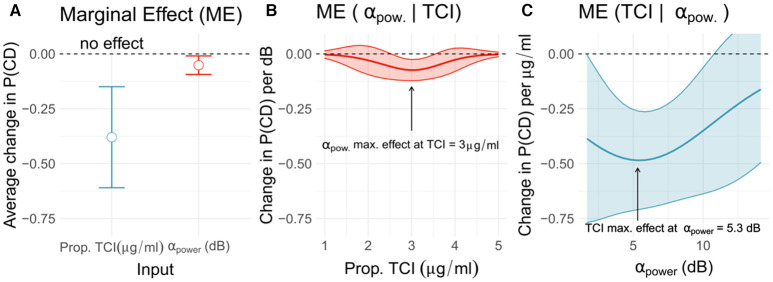
Marginal effects of TCI and alpha power of CD probability. The present triptych shows effect of TCI and AP on the patient's probability to be CD, estimated from the HELP model. On the panel (A), marginal effect means (circle) and standard deviation bar errors are reported for TCI (red) and AP (blue). The two variables contribute to predict the onset of CD among patients, although TCI appears to more strongly affect CD probability compared to AP. Panels (B,C) show conditional marginal effects reflecting change in one variable effect relatively to the other variable values. The AP effects is the most important at a TCI of 3 μg/ml
(B), while TCI strongly impact prediction for an AP of 5.5 dB. Consequently, effect of AP in predicting CD is not homogeneous as TCI changes, with a maximal effect near 3 μg/ml.